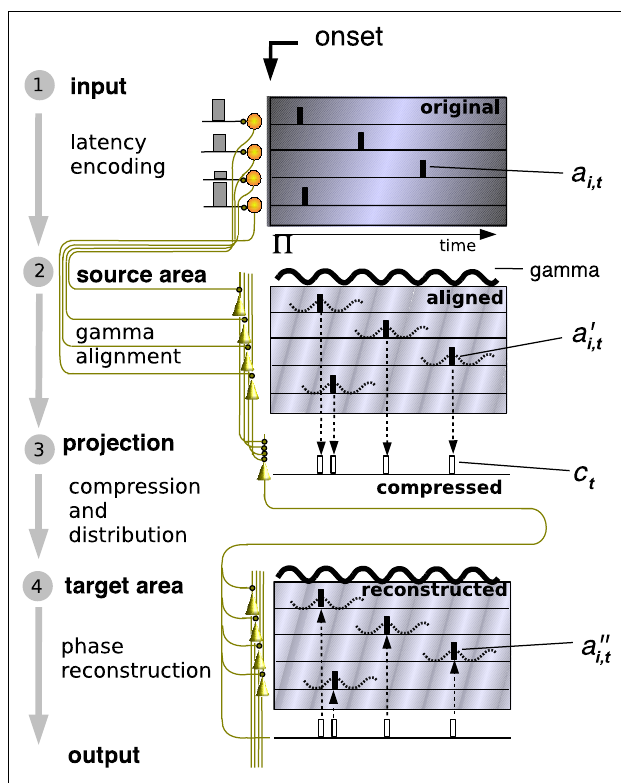
FIGURE 1 | Flow chart of information encoding and reconstruction. Stages are numbered at the left from 1 to 4. (1) Input: An intensity-modulated signal is presented to the input of the neurons and encoded as an AP latency vector ( a ) (Gollisch and Meister, 2008). (2) Source Area: The latency encoding i,t AP vector, when interacting with a propagating fi eld of local oscillations, becomes aligned to the nearest SMO peaks ( a ′ ). (3) Projection: The SMO- i,t aligned AP vector is collapsed into a single AP stream via convergent connections. At the same stage, the AP vector is distributed via divergent connections (not shown), and identical AP trains are transferred to the next stage ( c ) (Dan et al., 1998). (4) Target Area: this area receives identical copies t of the AP vector through parallel pathways. When APs interfere with the local waves of SMO, a single input AP evokes a single output AP only in neurons where the input AP coincides with the peak of the local SMO. Provided that the SMOs have the same voltage gradient at the input and target areas, it is guaranteed that the coincidence pattern will reconstruct the original spatio- temporal pattern of the input ( a ″ ). Output: As a result, the output AP vector i,t reliably reproduces the phase aligned input vector.